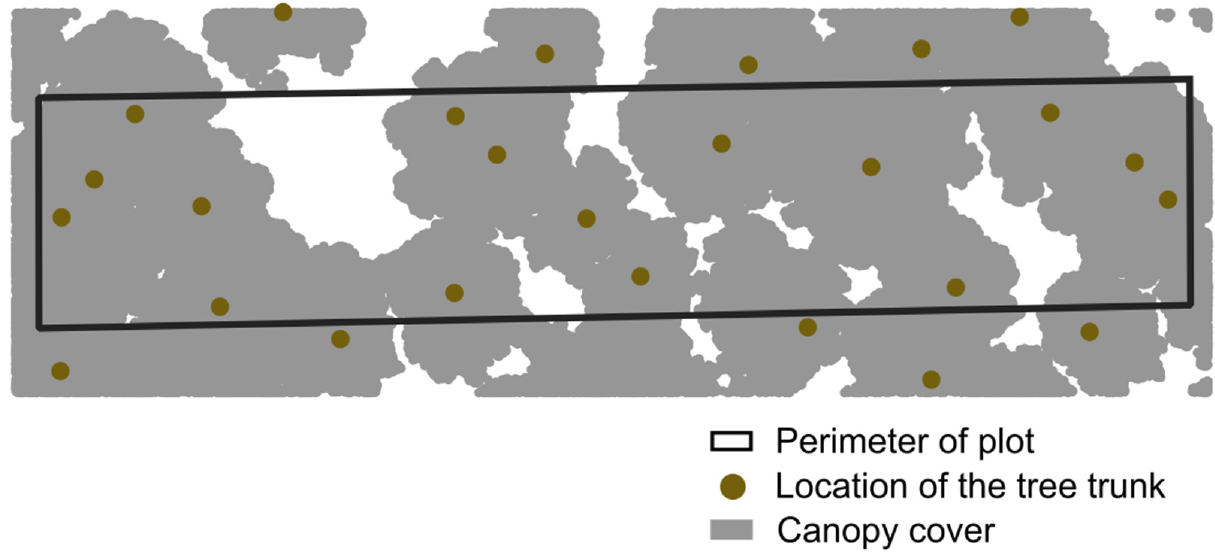
Figure 4. Canopy cover retrieved from the GeoSLAM point cloud (example from Plot 6). Brown points represent the tree trunks whose canopies (grey area) affect the plot.